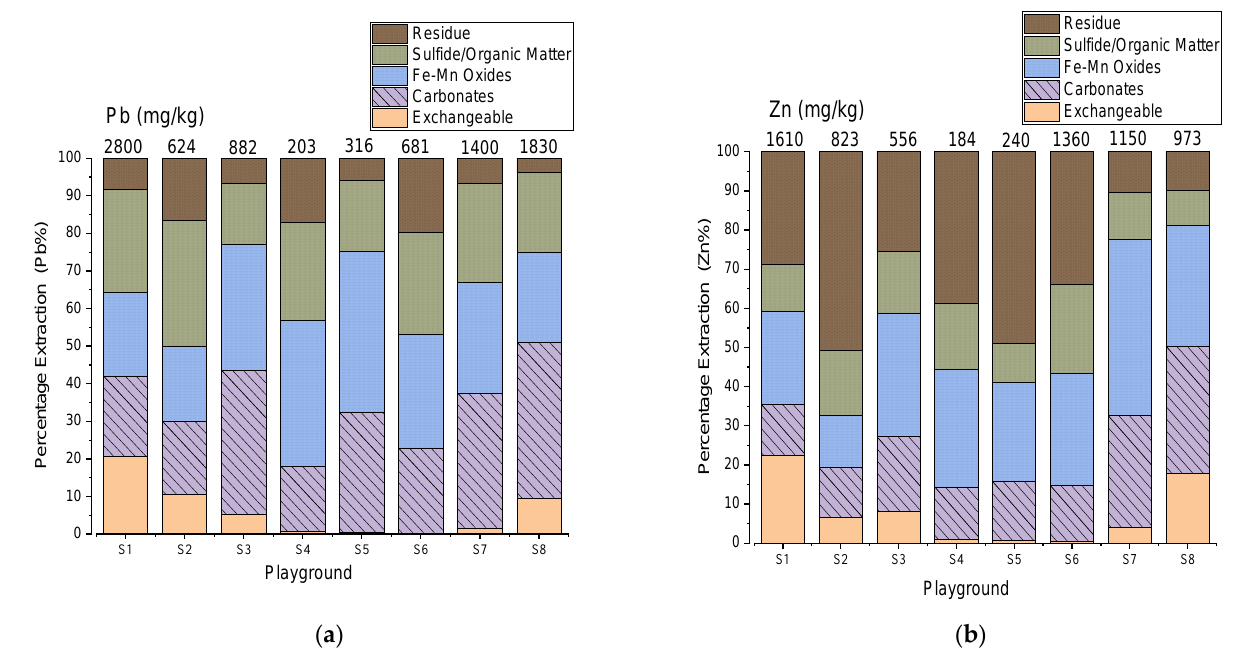
Figure 4. Solid-phase partitioning of Pb ( a ) and Zn ( b ) in SPs. The values on top of each sample represent the total content (mg/kg) from the extraction of the five phases. The phases are expressed in percentage of the total content.